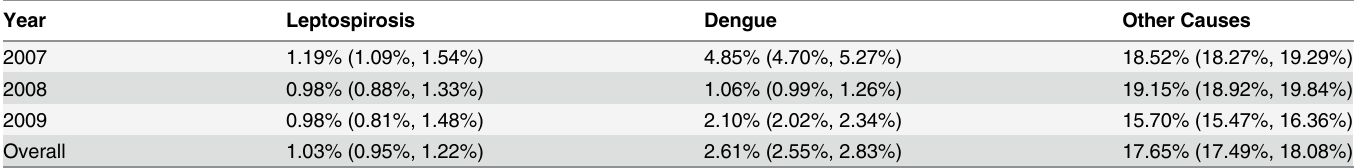
We estimated that the probability of having a fever caused by leptospirosis was 1.03% (95% Credible Interval CI: 0.95% -1.22%) per semester. In comparison, it was 2.61% (95% CI: 2. 55% – 2.3%) for dengue and 17.65% (95% CI: 17.49% -18.08%) for other causes (Table 3). The risk of fever caused by dengue was found to be reduced by 95% (95% CI: 84% – 98%) following the occurrence of a fever caused by dengue. The risk of fever caused by leptospirosis or by other causes was relatively constant across seasons, unlike the risk of fever caused by dengue which varied from 1.06% in 2008 to 4.85% in 2007. Table 3. Semestrial probability of having a fever caused by leptospirosis, by dengue or by another cause. We provide the posterior mean and 95% Credible Intervals (95% CI). Technical details are presented in S1, S2 and S3 Tables.